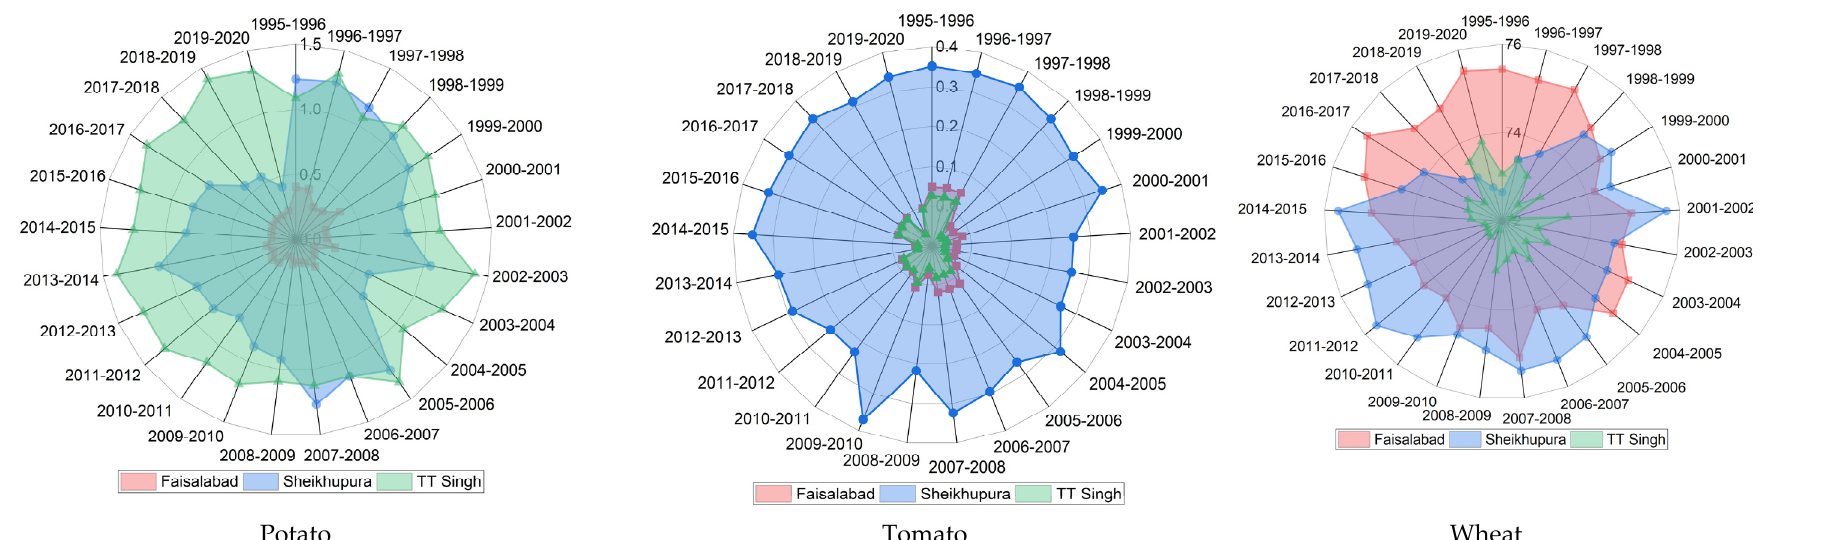
Figure 10. Change in cropping pattern percentages of both Kharif and Rabi crops in Faisalabad, Sheikhupura, and Toba Teik Singh for both Rabi and Kharif crops.